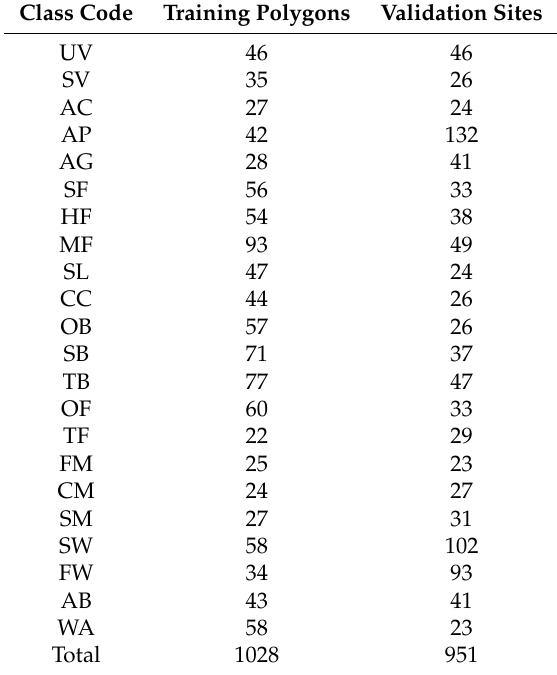
Table 7. Number of training polygons and validation GPS sites for each